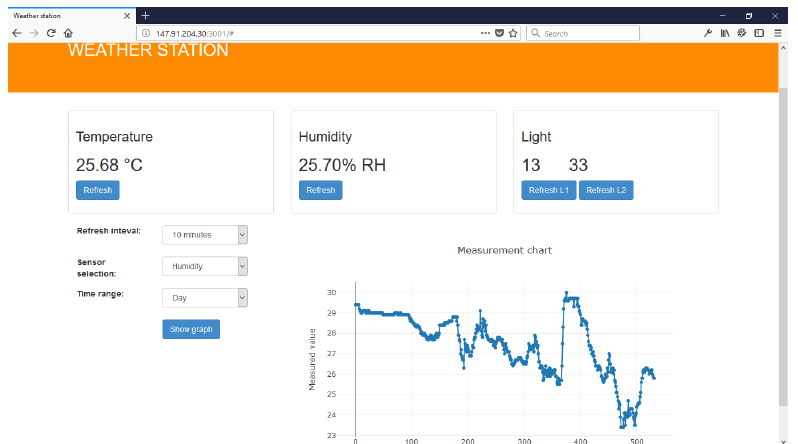
Fig. 4. Weather station hardware setup